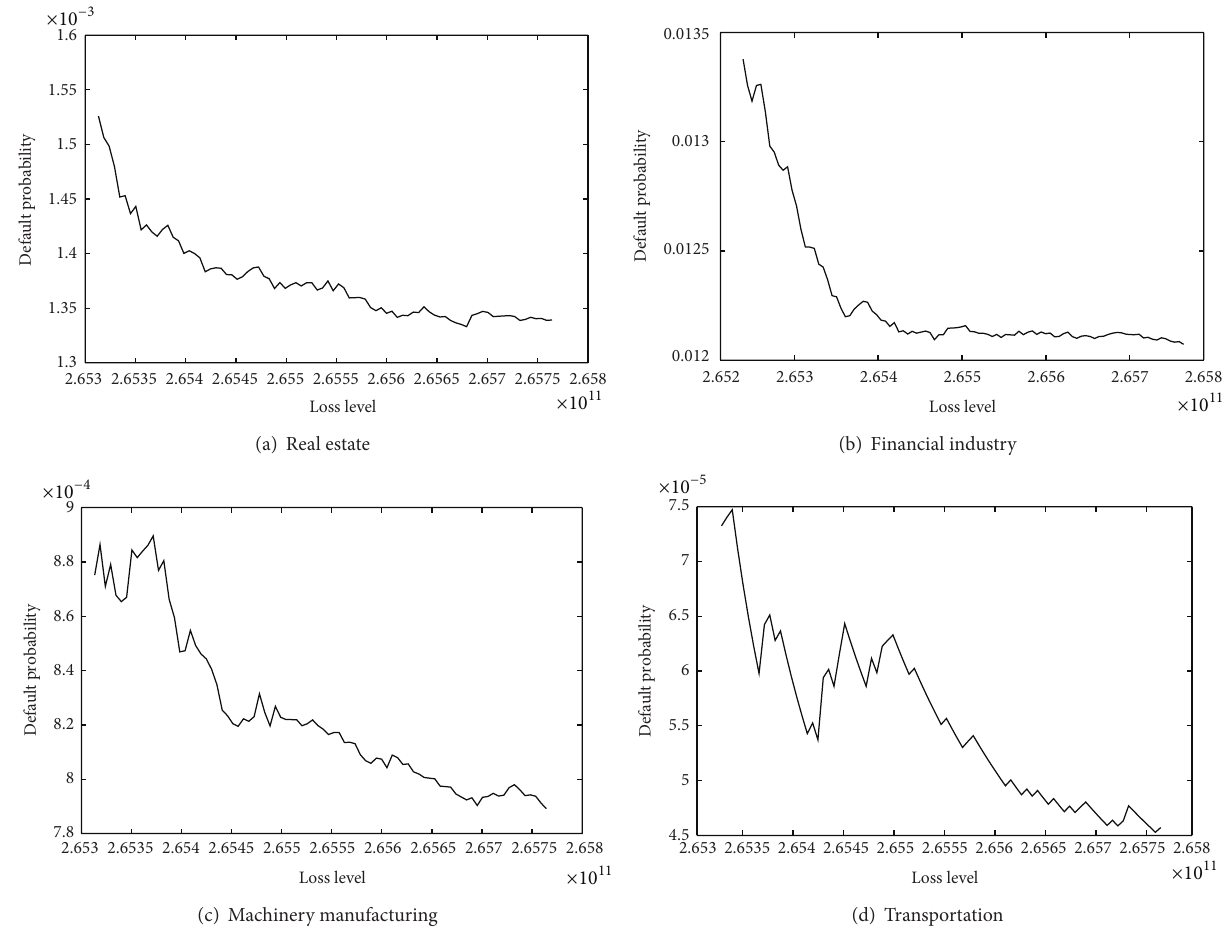
Figure 3: Loss distributions of each sample portfolio under Monte Carlo